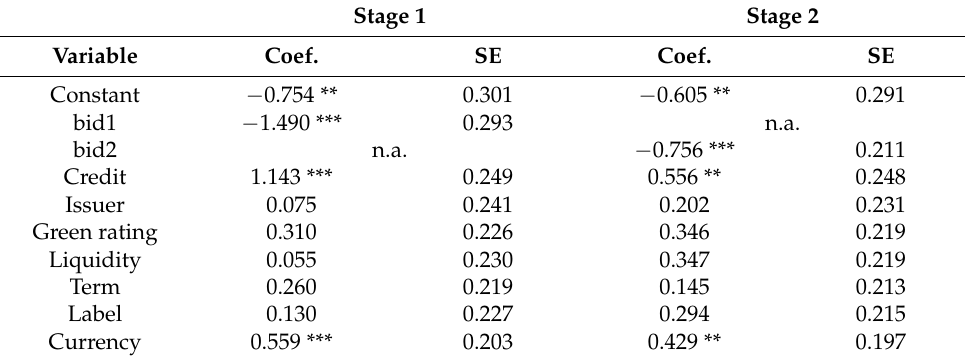
Table 8. Logit model estimation for Model